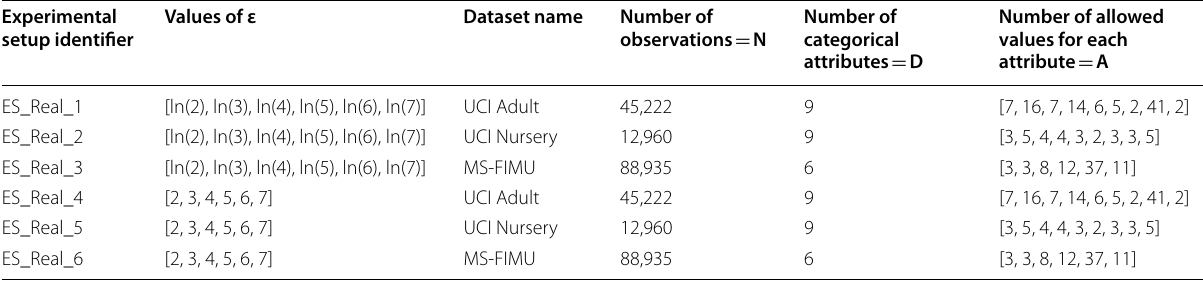
Table 1 The various parameter values that comprised the experimental setup were tested on real-world datasets Experimental setup identifier